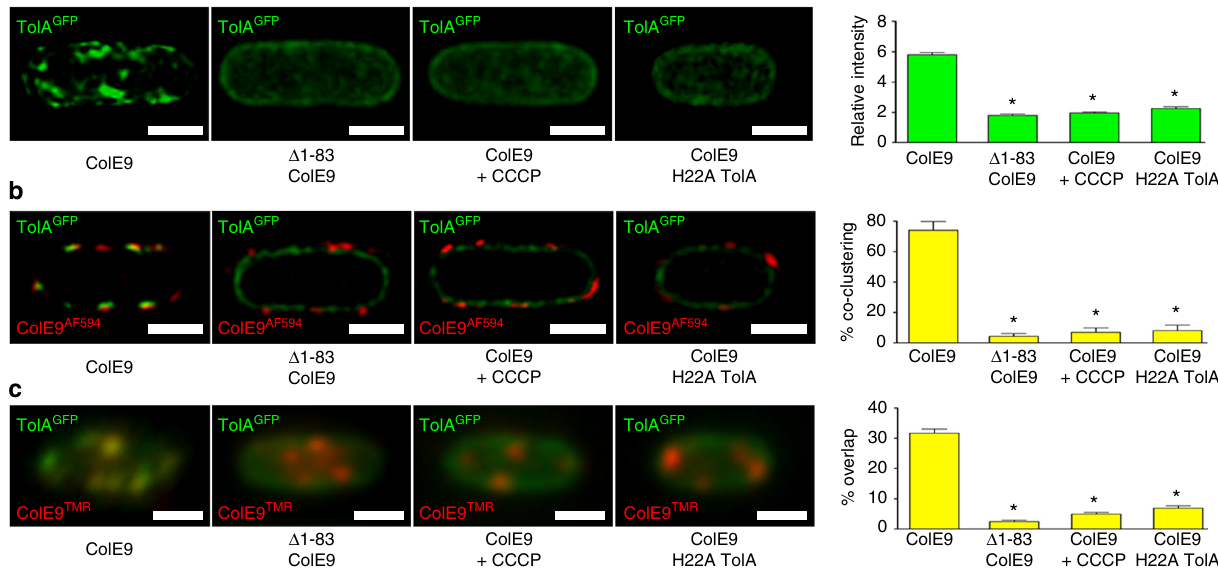
Fig. 3 ColE9/OMP-induced organisation of TolA in the IM requires the PMF. Panels show JW0729/pNP4, pRP5 cells expressing GFP-TolA (not induced) and BtuB (induced), respectively, bound with ColE9 AF594 and visualised by ( a ) 3D-SIM (GFP fl uorescence only), ( b ) 2D-SIM z -slices (GFP-TolA and ColE9 AF594 fl uorescence) and ( c ) TIRFM data (GFP-TolA and ColE9 TMR fl uorescence). First column, addition of ColE9 AF594 alone. Second column, addition of Δ 1-83 ColE9 TMR/AF594 in which the connection to TolA is broken, resulting in the loss of both GFP-TolA clustering and GFP-TolA-ColE9 TMR/ AF594 co-localisation. Third column, addition of CCCP (0.1 mM) destroys the PMF yielding a similar effect to that of the Δ 1-83 ColE9 TMR/AF594 mutant. Fourth column, addition of ColE9 TMR/AF594 to E . coli JW0729/pREN88, pRP5 cells expressing GFP-H22A TolA (uninduced) and BtuB (induced), respectively. Scale bars, 1 μ m. Asterisk, p < 0.01 from a Student ’ s t test for n = 30 cells shown in each set of data in the accompanying